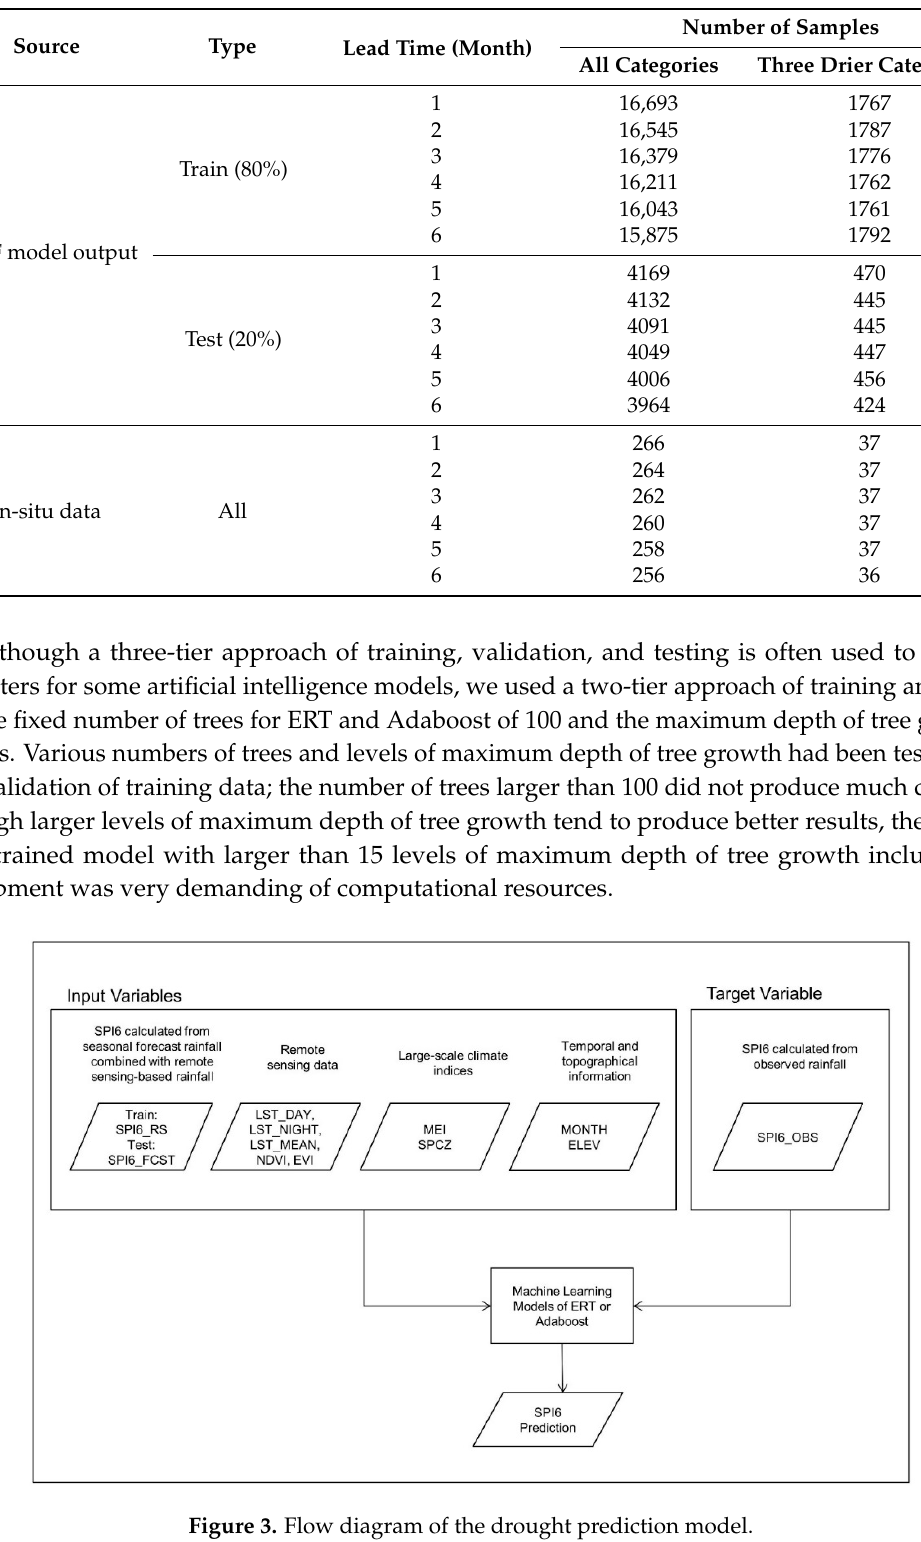
Table 3. Numbers of data samples used for training and testing.